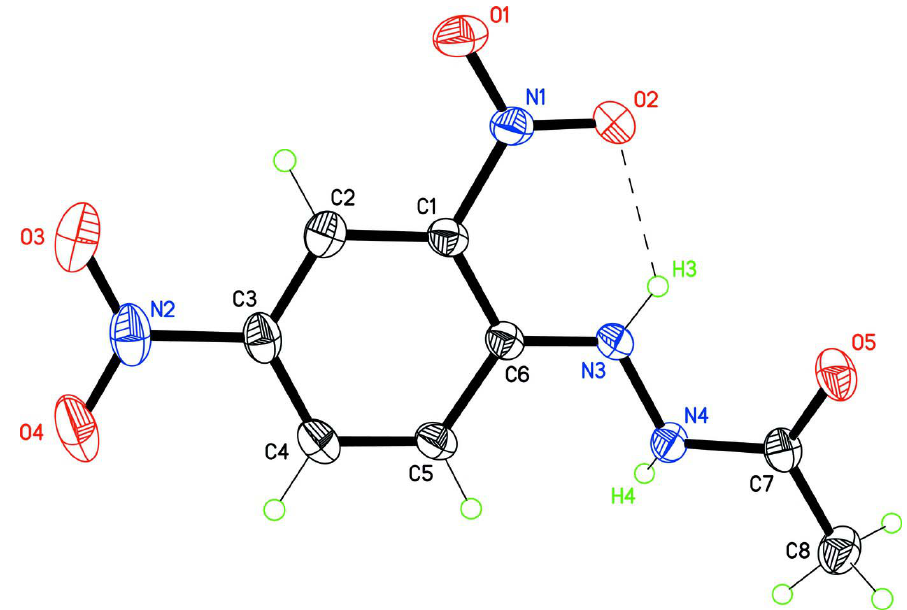
The asymmetric unit of the title compound showing the intramolecular hydrogen bond. Displacement ellipsoids are drawn at the 50% probability